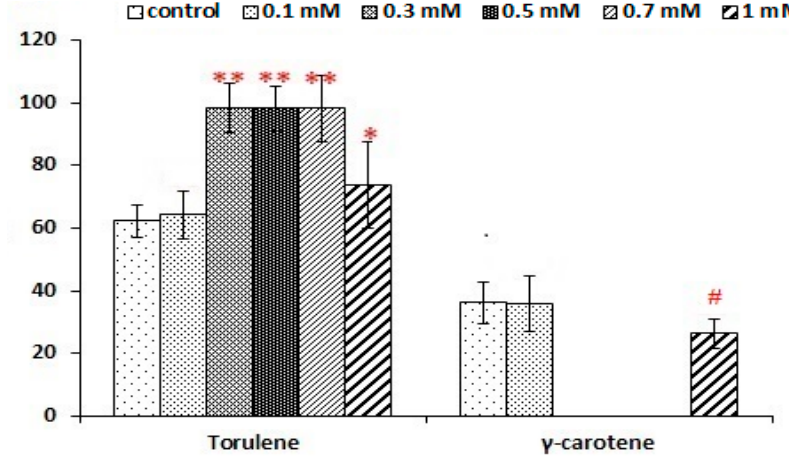
Figure 5. The percentage of individual carotenoids, γ -carotene and torulene, in the carotenoid profile extracted from Rhodotorula glutinis . Yeast cells were grown in a shaken flask under different Al 2 (SO 4 ) 3 concentrations in the optimised media using optimised media as a control. The data are the mean of two repeat tests, and the standard deviation was calculated and represented as an error bar. Asterisks ** represent a statistically significant difference between the single-Al-treated group and control at p ≤ 0.01 in the case of torulene, and hash # represents a statistically significant difference between the single-Al- treated group and control at 0.01 < p ≤ 0.05 in the case of γ -carotene. Memorably, after adding aluminium sulfate into the optimized medium, a characteristic intense red pigmentation of yeast pellets was observed, which indicated the e ff ect of the new conditions on both the carotenoid composition and concentration (Figure